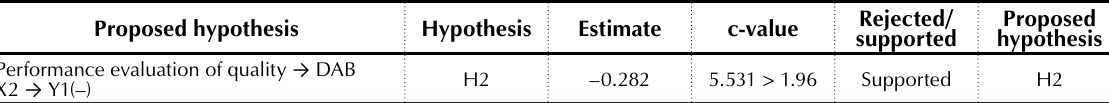
Table 2. Path coefficient of performance evaluation of quality focus and DAB Proposed hypothesis